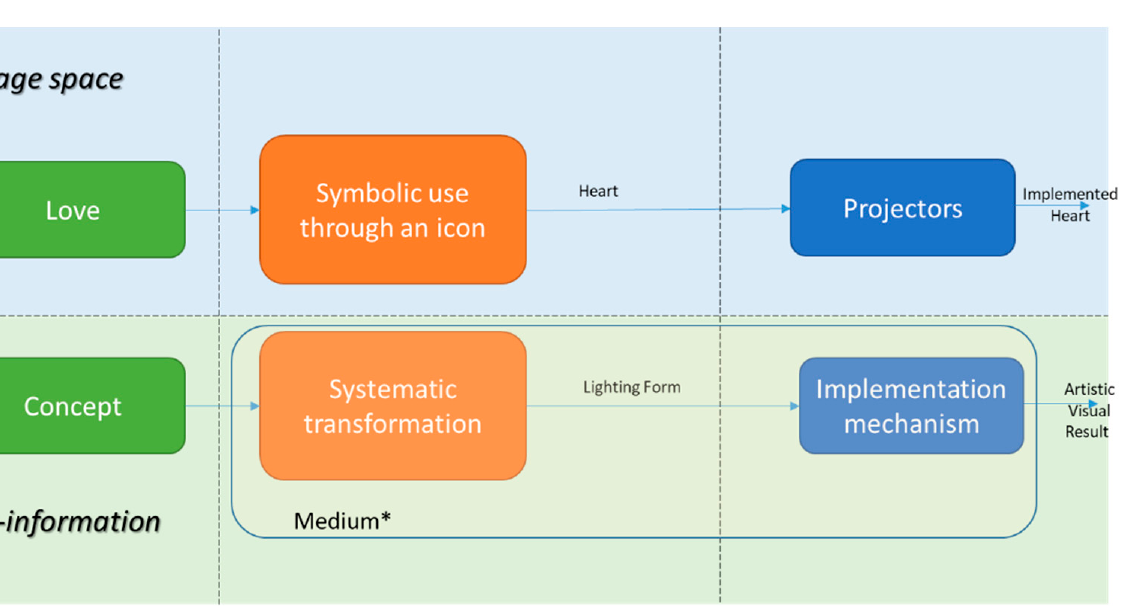
Figure 38. The modules of a working diagram: a semantics-based interpretation.